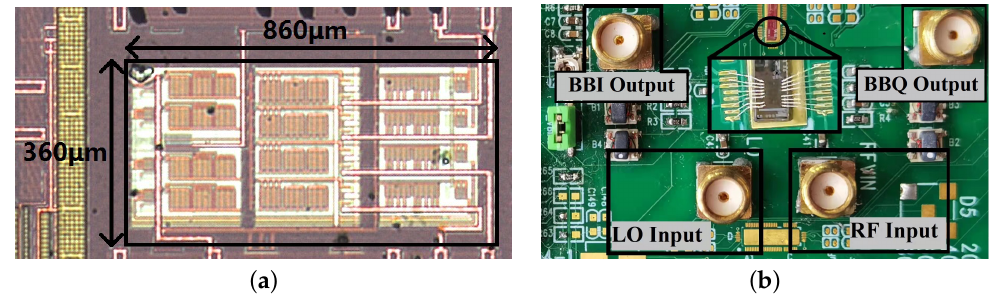
Figure 8. ( a ) Chip micrograph. ( b ) Assembled PCB for testing.